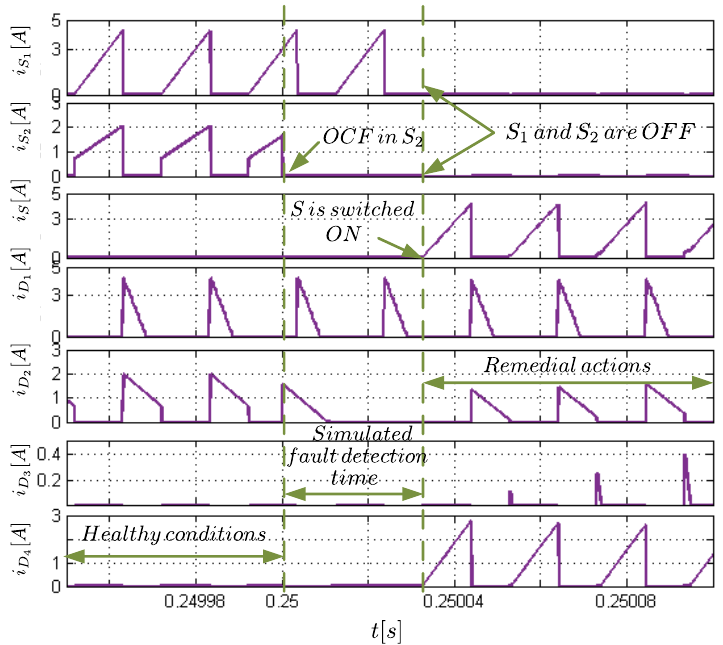
Figure 18. OCF in S 2 at t = 0.25 s: currents in the switches and the diodes.